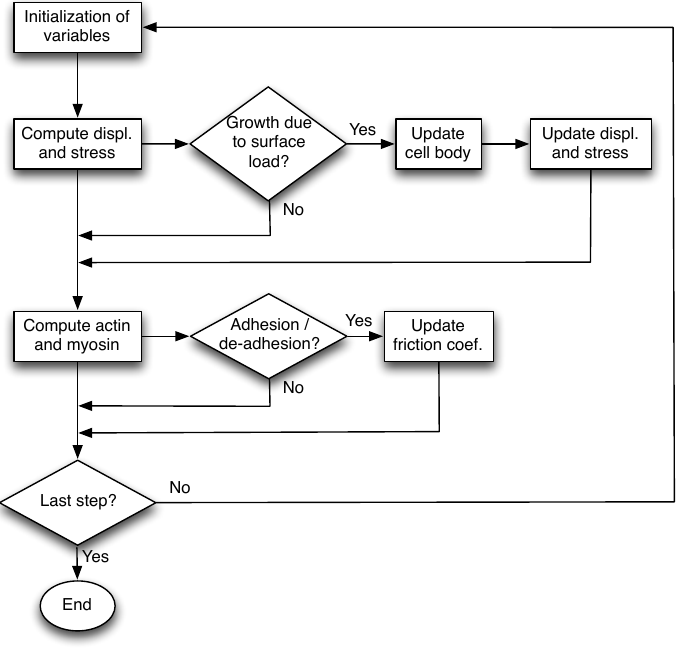
Figure 4. Flowchart of the numerical